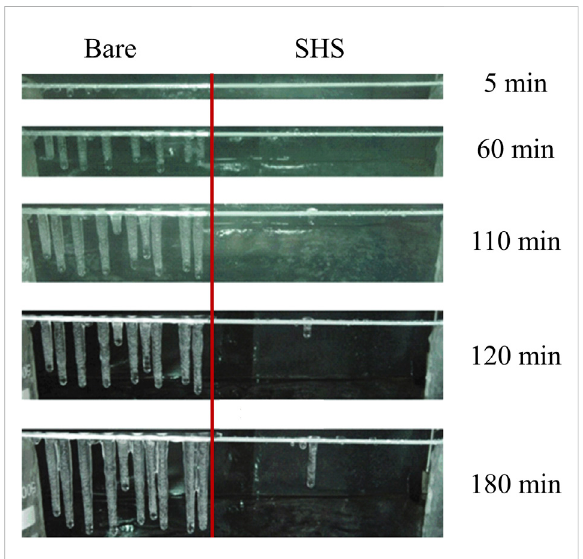
FIGURE 1 The icing process on the conductor in the icing simulation test(theleftsideoftheredlineistheuntreatedconductor,andthe right side is the prepared superhydrophobic conductor) (Jin et al.,